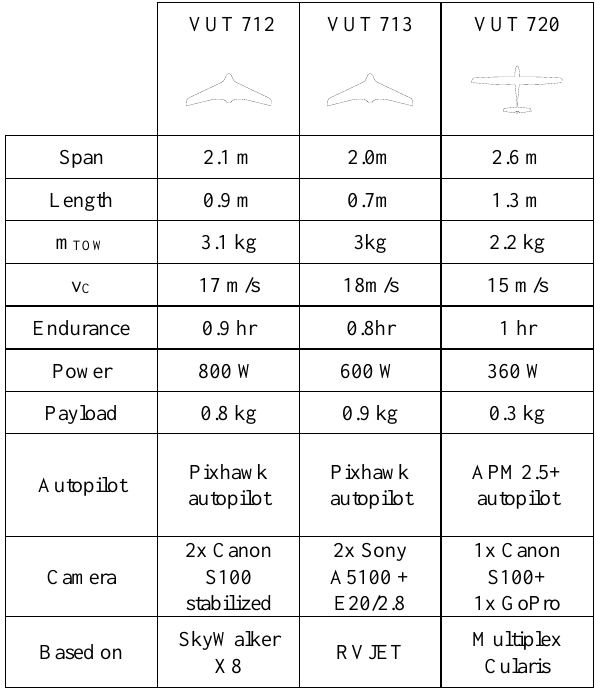
Table 1. Small VUT unmanned platforms for invasive species